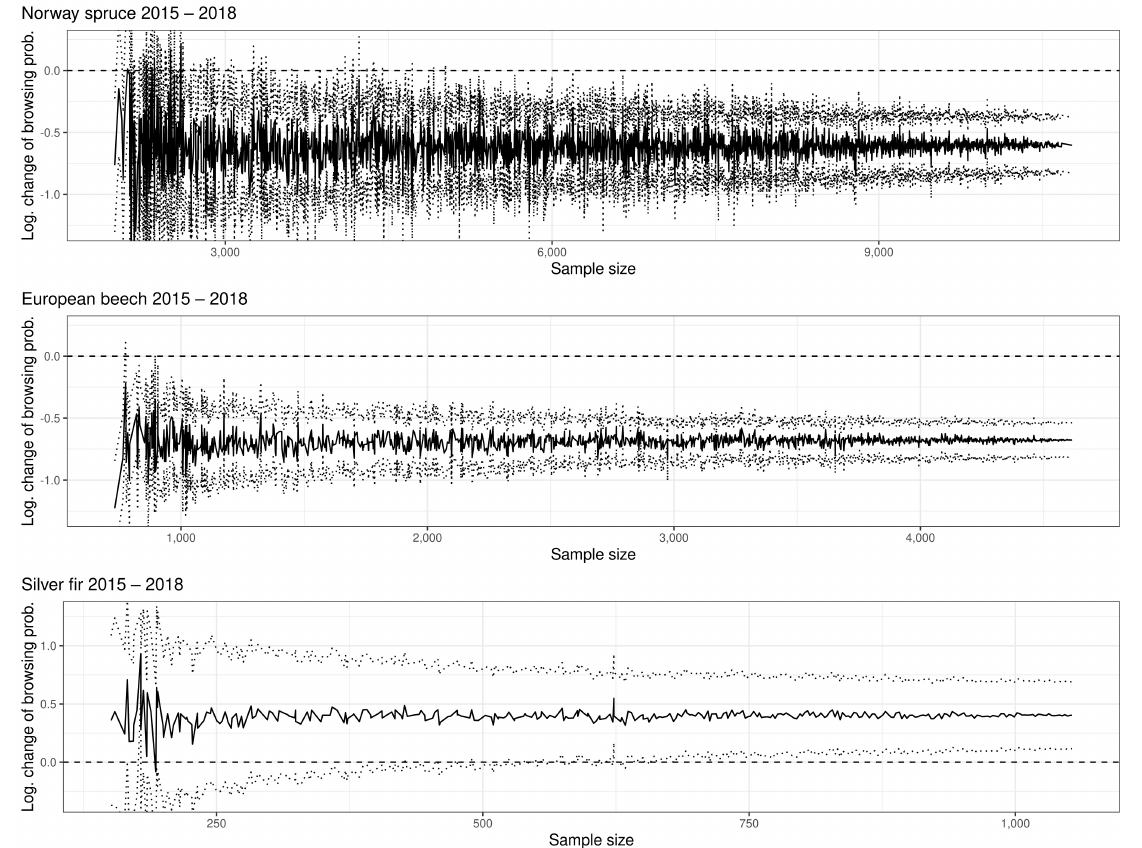
Figure A8. The results of the sensitivity analysis for the BP change of all tree species for which its change was tested as significant between 2015 and 2018. The sample size is on the x -axis and the estimates of the confidence intervals (dashed) of the logarithmic BP change is on the y